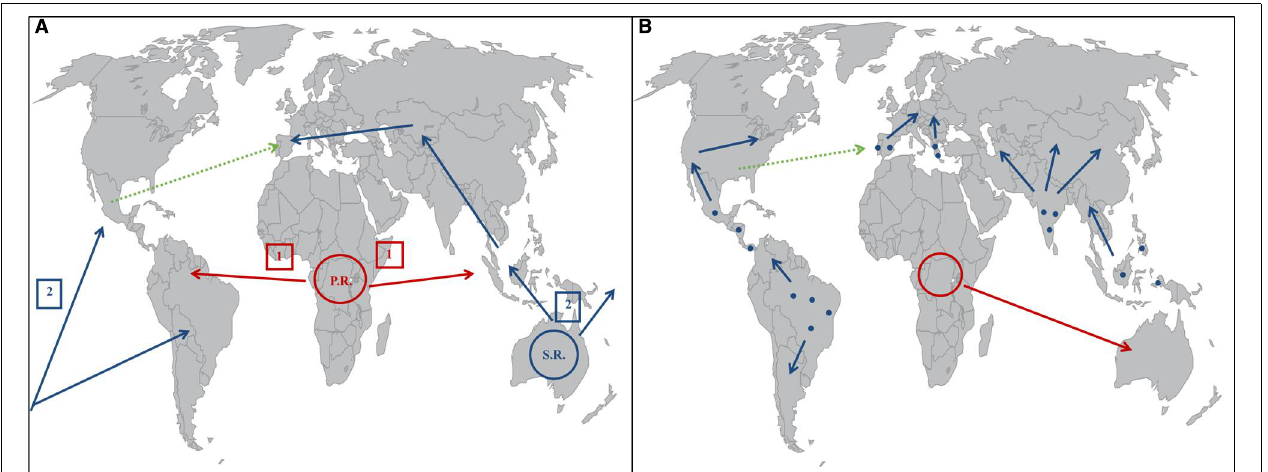
FIGURE 2 | (A) Global expansion routes of C. raciborskii according to Padisák (1997) with a primary radiation center (P.R.) based in Africa, and a secondary radiation center (S.R.) based in Australia. The green arrow represents posterior migratory movements, according to Cirés et al. (2014). (B) Global expansion routes of C. raciborskii according to Haande et al. (2008). Blue points represent